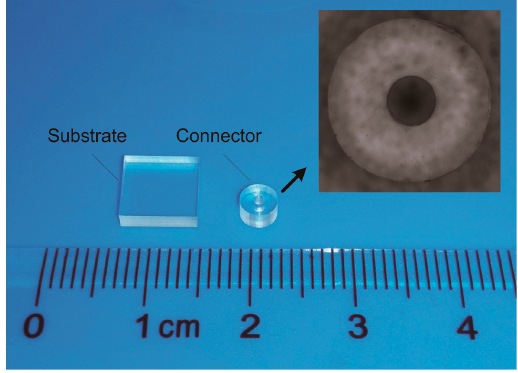
Figure 1. Micro connector and substrate for bonding experiments.